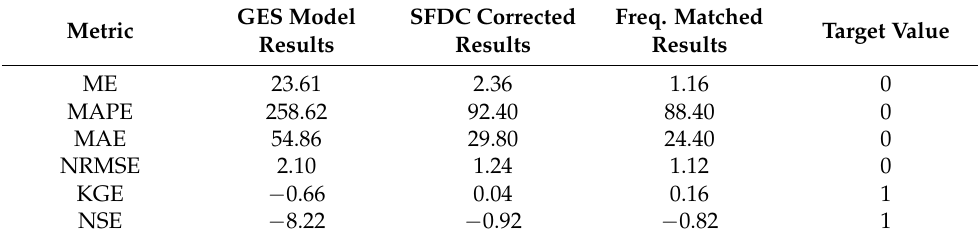
Table 2. Magdalena River median error metrics for each test